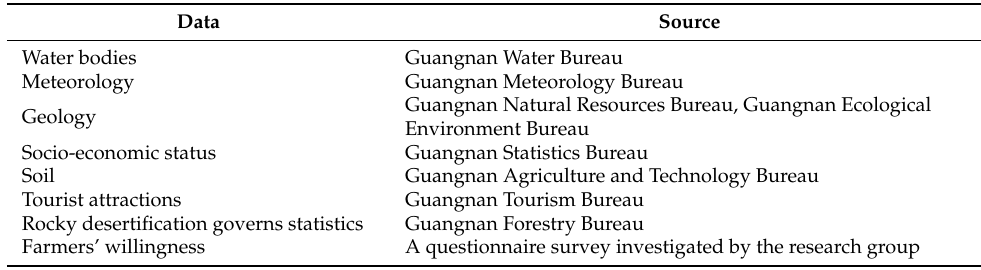
Table 1. Main data and